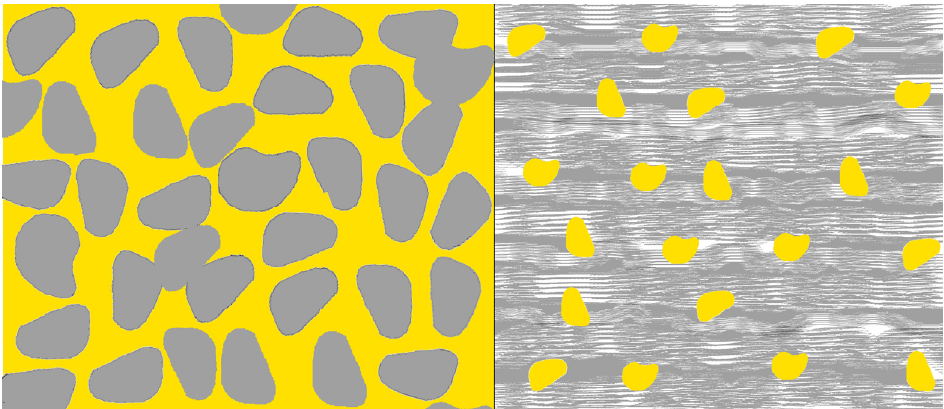
Figure 1. Schematic structure of conventional ( left ) and unconventional ( right ) gas reservoir.